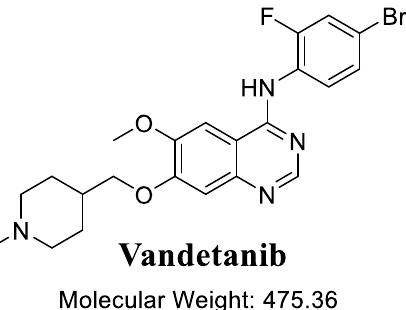
Figure 1. Chemical and molecular structure of vandetanib (VNB).